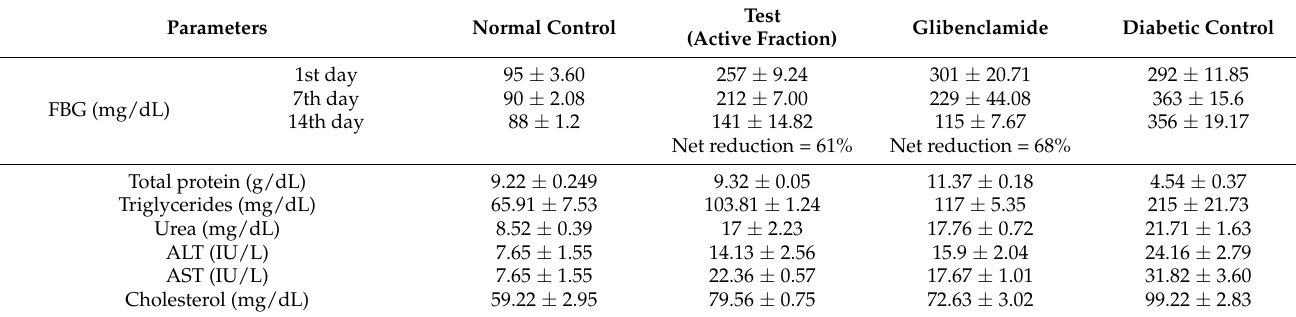
Table 5. Effect of active fraction (F4) on STZ-induced diabetic